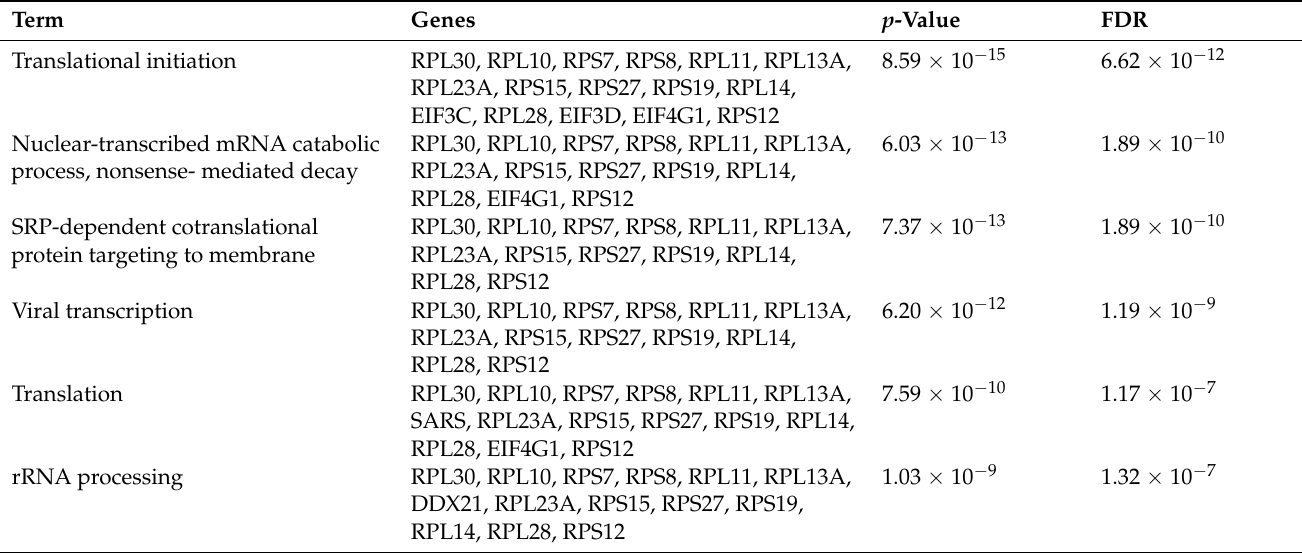
Table 4. The ontology analysis of proteins differentially expressed in female lesional and uninvolved skin. The analyzed proteins were differentially expressed in female lesional and uninvolved skin and were not differentially expressed in male lesional and uninvolved skincompared to the skin of healthy